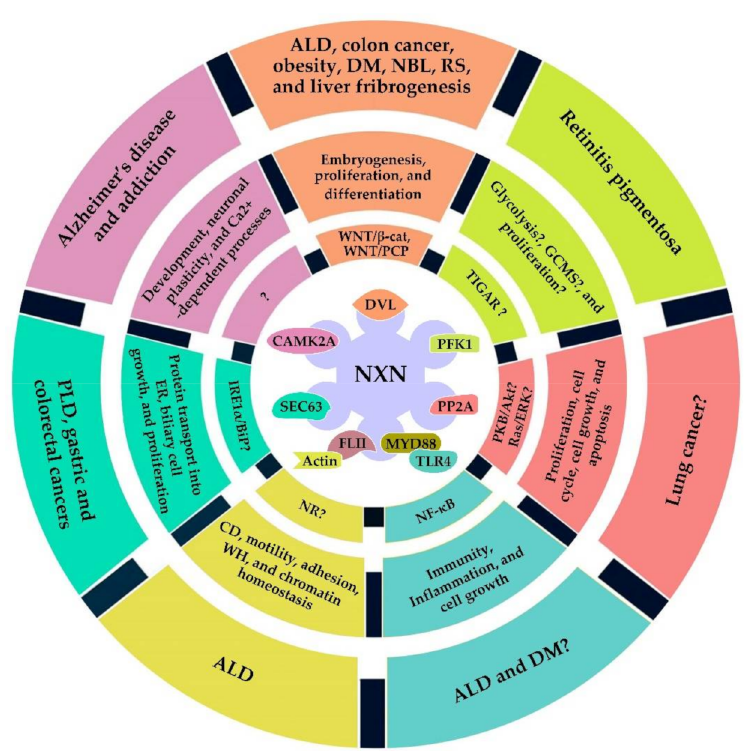
Figure 4. Schematic representation of NXN interactions, involved signaling pathways, cellular pro- cesses, and associated diseases. NXN/DVL interaction regulates WNT signaling which influences embryogenesis, proliferation, and differentiation processes, and it has been associated with the pro- gression of alcoholic liver disease (ALD), colon cancer, diabetes mellitus (DM), neuroblastoma (NBL), Robinow syndrome (RS), and liver fibrogenesis. NXN/PFK1 interaction could be regulating processes such as glycolysis, global cell metabolic state (GCSM), and proliferation through the participation of TP53-induced regulator of apoptosis and glycolysis (TIGAR); this interaction might be associated with retinitis pigmentosa development. NXN/PP2A interaction is likely involved in proliferation, cell cycle, cell growth, and apoptosis through PKB/Akt and Ras/Raf/MEK/ERK signaling regulation, and it could be associated with lung cancer development. FLII/NXN/MYD88 interaction regulates NF- κ B signaling; as a consequence, influences immunity, inflammation, and cell growth processes; additionally, it might also be influencing cytoskeletal dynamics (CD), motility, adhesion, wound healing (WH), and chromatin homeostasis by regulating NR-dependent signaling. It is implicated in the early progression of ALD, and could be involved in DM development. NXN/SEC63 interaction is likely involved in the activation of IRE1 α /BiP signaling which regulates protein transport into ER, biliary cell growth and proliferation, and it might be associated with polycystic liver disease (PLD), gastric and colorectal cancer. NXN/CAMK2A interaction could influence neuronal develop- ment, plasticity, and CA2+-dependent processes, and it is likely implicated in the development of Alzheimer’s disease (AD), and other psychiatric diseases such as